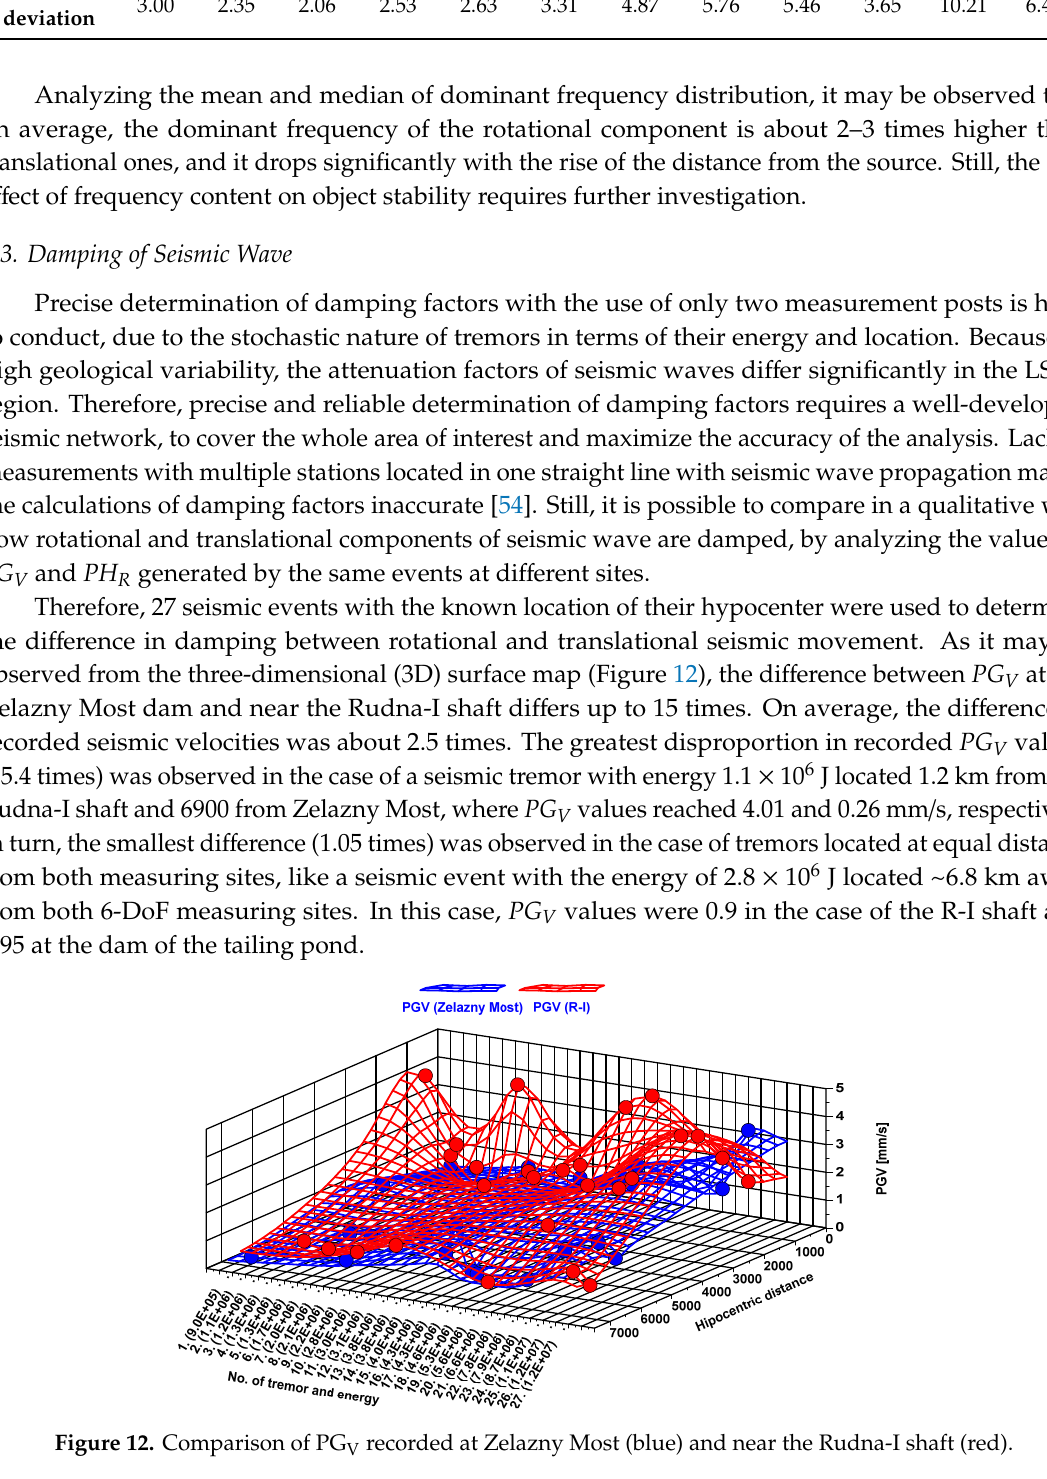
Table 2. Descriptive statistics of dominant frequency distribution at both measuring